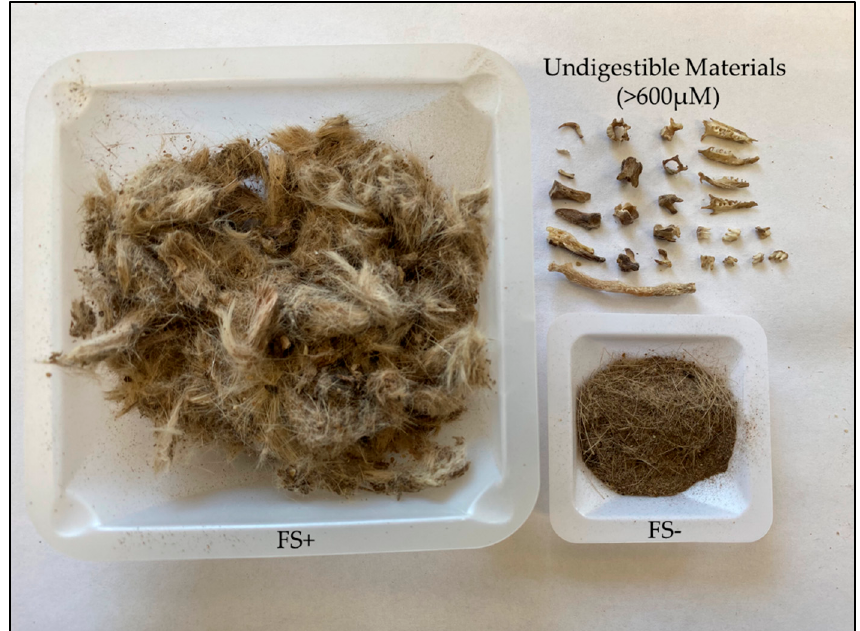
Figure 1. Captured image of separated fecal remains with undigestible materials removed. Dried sifted fecal sample (lower right corner; FS − ) was reduced compared to the fecal sample containing undigestible materials (left; FS+). Undigestible materials consist of keratinized materials including hair, toenails and bone; >600 μ M (upper right corner).